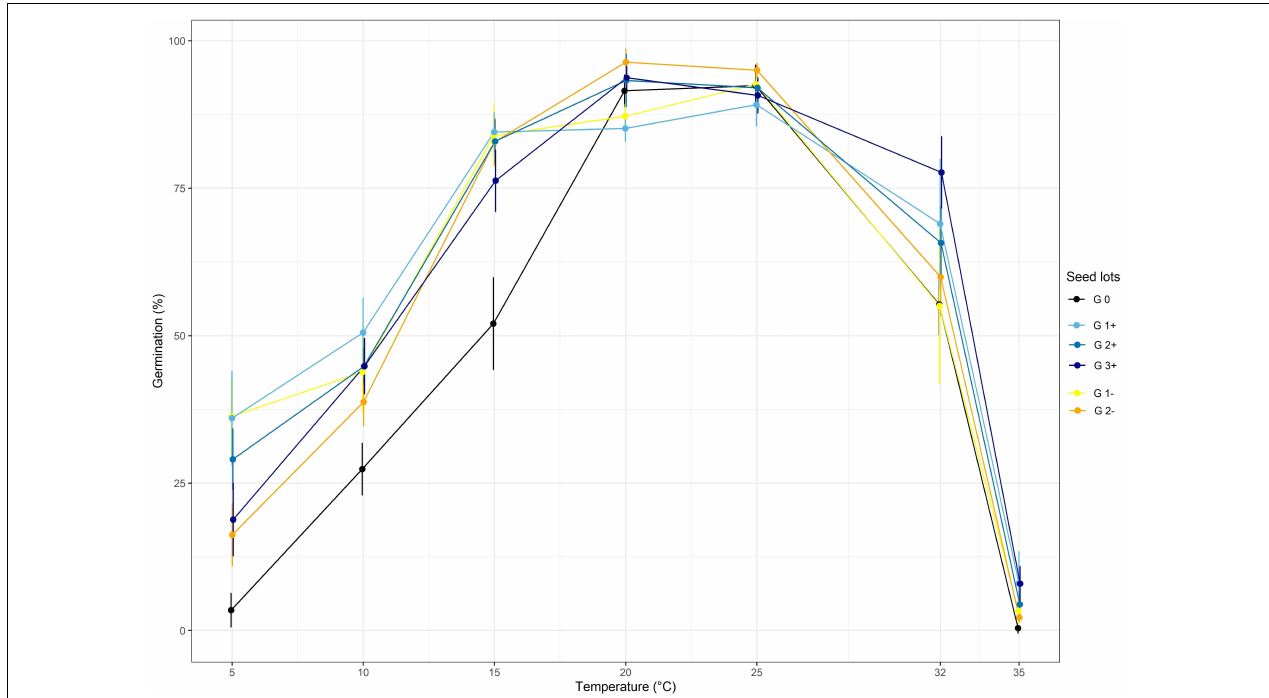
FIGURE 3 | The effect of divergent selection at 32 ◦ C on the seed germination percentage of all the populations obtained from positive selection (G1+, G2+, G3+) and negative selection (G1-, G2-). G0 corresponds to the initial population.